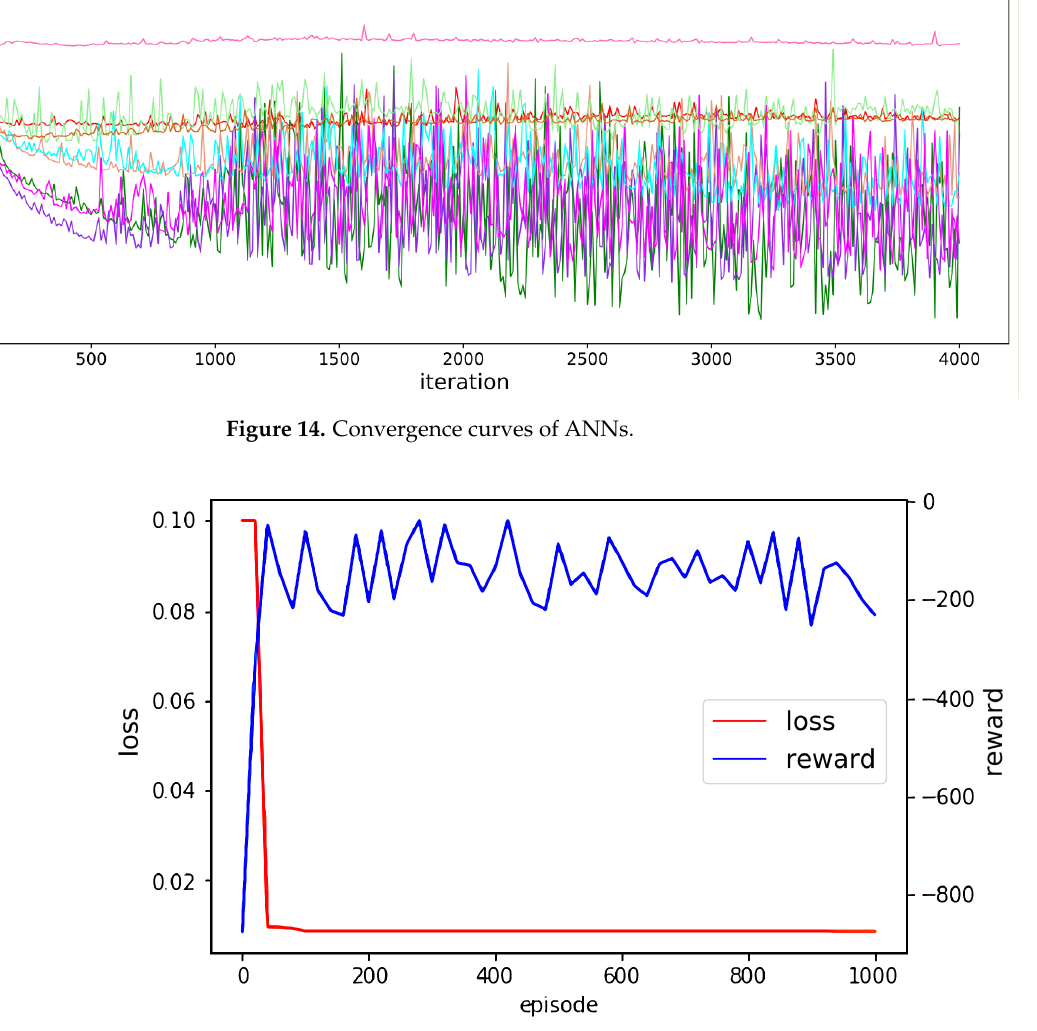
Figure 15. The accumulative reward and objective function loss of each episode. With the ANN-based surrogate model and the DDPG based optimization, a new rotor blade profile with lower total pressure loss coefficient and larger laminar flow area is achieved. By CFD validation, the performance characteristics and the flow field character- istics of the cascade with the optimized blade profile can be known and compared with the original